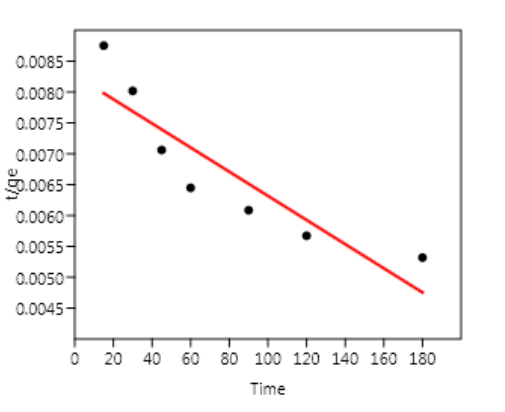
Figure 8. The pseudo-first-order kinetics of the adsorption of phosphate by chitosan-activated carbon nanocomposite